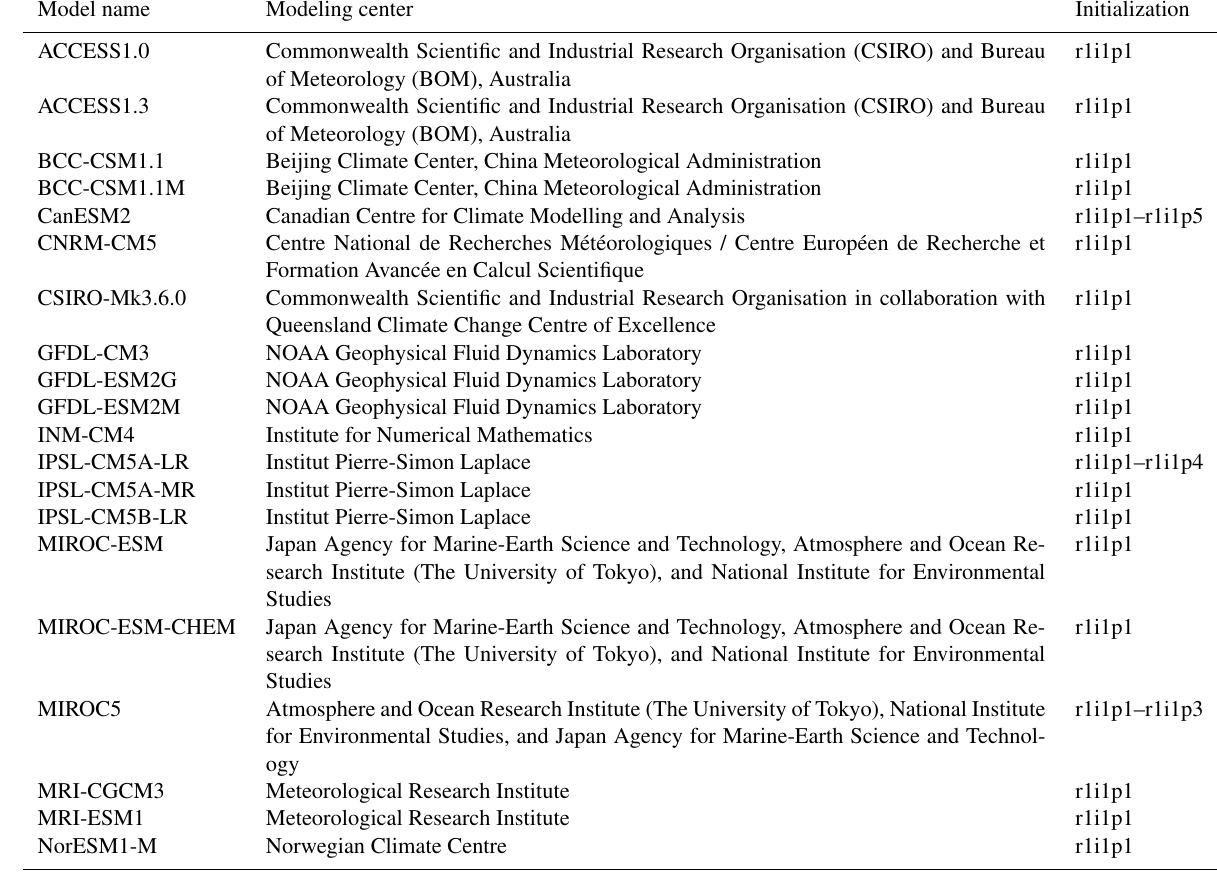
Table A1. The 29 CMIP5 models used in this study. We use daily data from the historical simulation during the period